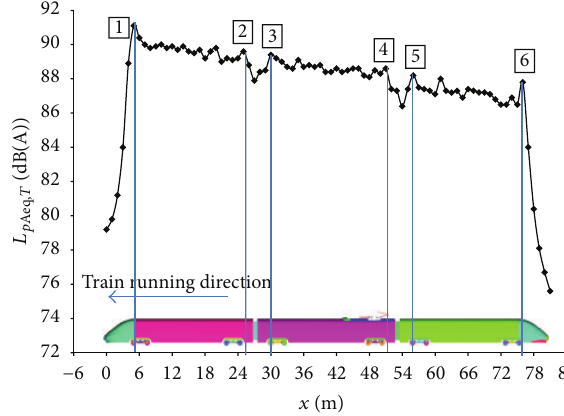
Figure 11: SPL distribution along the high-speed